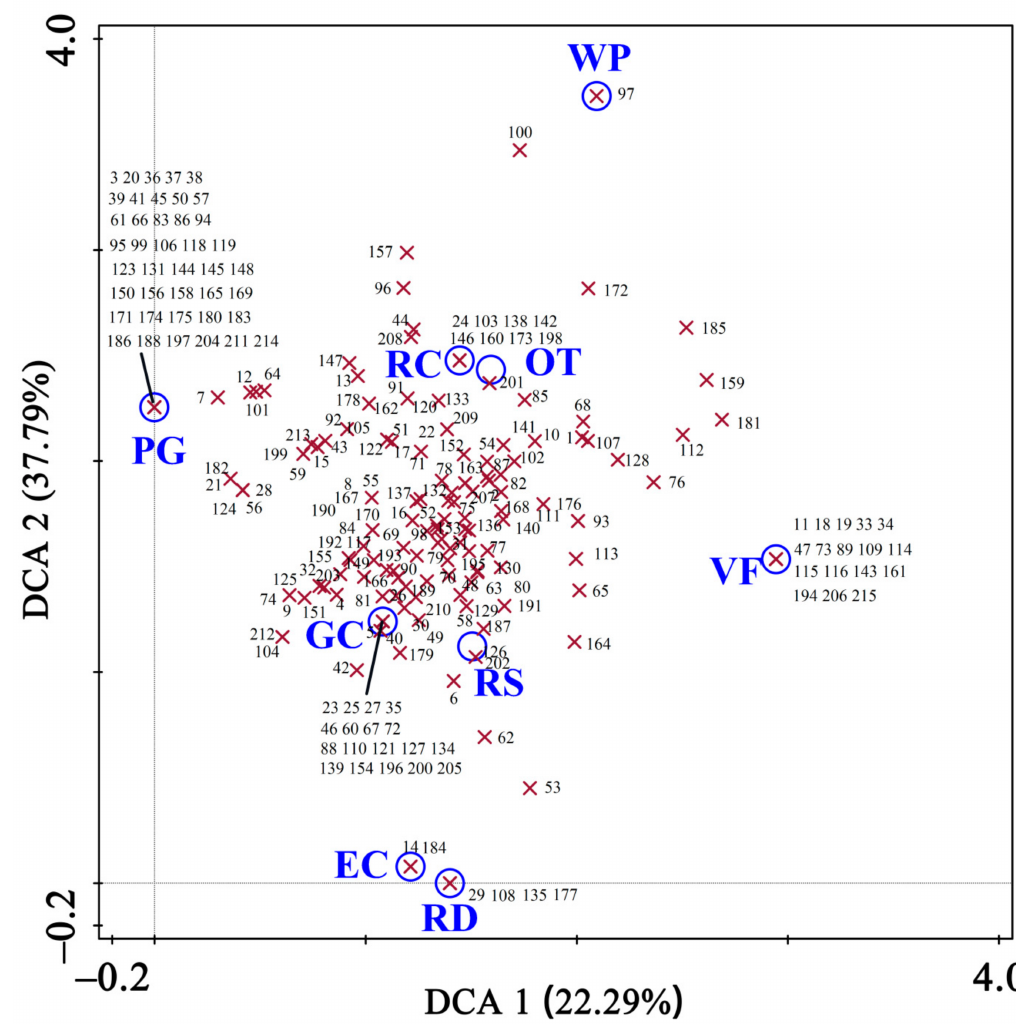
Figure 8. The first two axes of the DCA ordination of nine tree habitats and heritage tree species composition in Jiangsu Province, eastern China. Tree habitat types are presented as circles, and species as crosses. Refer to Table 3 for the meaning of the abbreviated tree habitats, and Table A1 for the numerical order of species